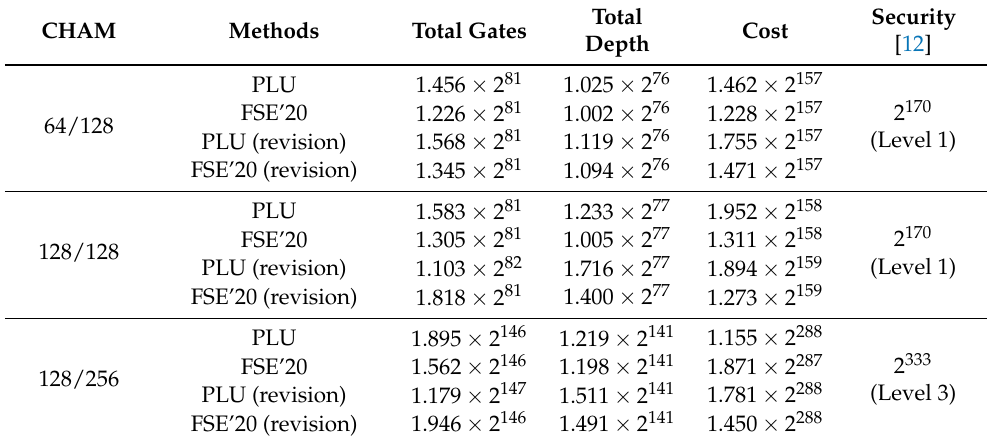
Table 5. Comparison of cost of Grover’s key search by methods applied to key-schedule for CHAM. CHAM Methods Total Gates